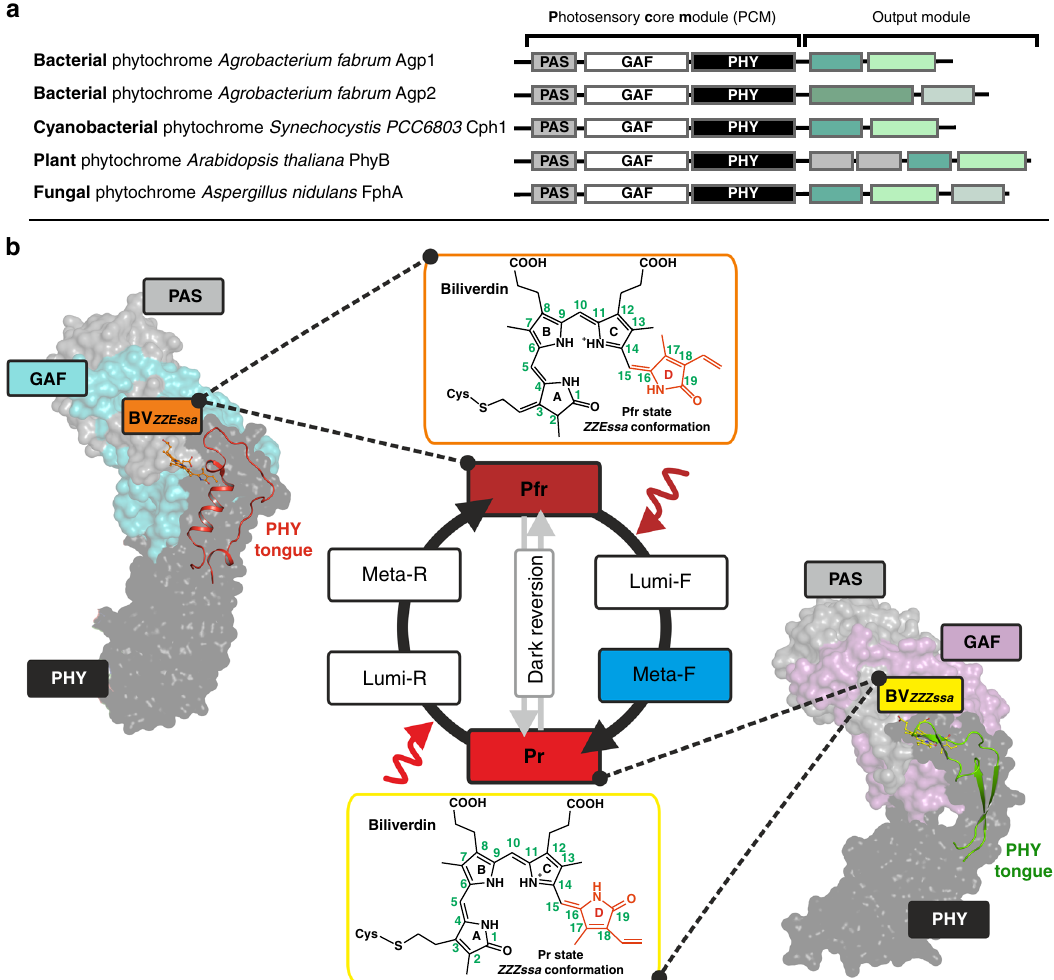
Fig. 1 Domain arrangement and overview of the phytochrome photocycle. a Domain arrangement of different phytochromes. The highly conserved photosensory core module (PCM) is subdivided into PAS, GAF and PHY domains; the C-terminal output modules differ between phytochromes but contain in most cases a histidine kinase (HK) or HK-like module. b Overview of the photocycle of phytochromes. For Pfr and Pr states, the overall folds of representative PCM constructs are depicted in surface representation (Pfr state based on wild-type Agp2-PCM: PDB entry 6G1Y, PAS in grey, GAF in cyan, PHY in black; Pr state based on Agp1-PCM SER13 : PDB entry 5HSQ 30 , PAS in grey, GAF in magenta, PHY in black). The secondary structure changes within the PHY tongue (elongated part of the PHY domain) that occur during the last steps of the Pr/Pfr photo-transformation are highlighted in cartoon representation (Pfr: α -helix, loop and coiled structure - red, Pr: β -sheet and β -hairpin - green). The structure of the biliverdin (BV) chromophore in the Pfr and Pr state is shown above and underneath the photocycle scheme, respectively. The chemical structure of BV is represented by only one of their resonance structures